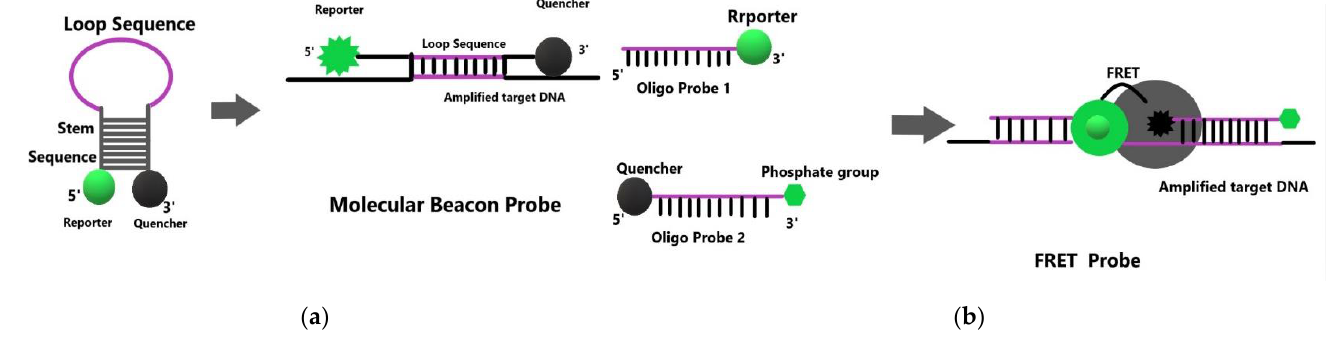
Figure 3. ( a ) Detection principle of Beacon probe ( b ) Detection principle of FRET probe. Fluorescence quenching can lower the intensity of emitted light from fluorescent molecules. Fluorescence quenching can cause some changes including fluorescence intensity, related excitation peak changes, and fluorescence peak position changes. The substances react with fluorescent materials causing these changes and these processes are called fluorescence quenchers. For example, electron acceptors are fluorescence quenchers in photosynthesis.